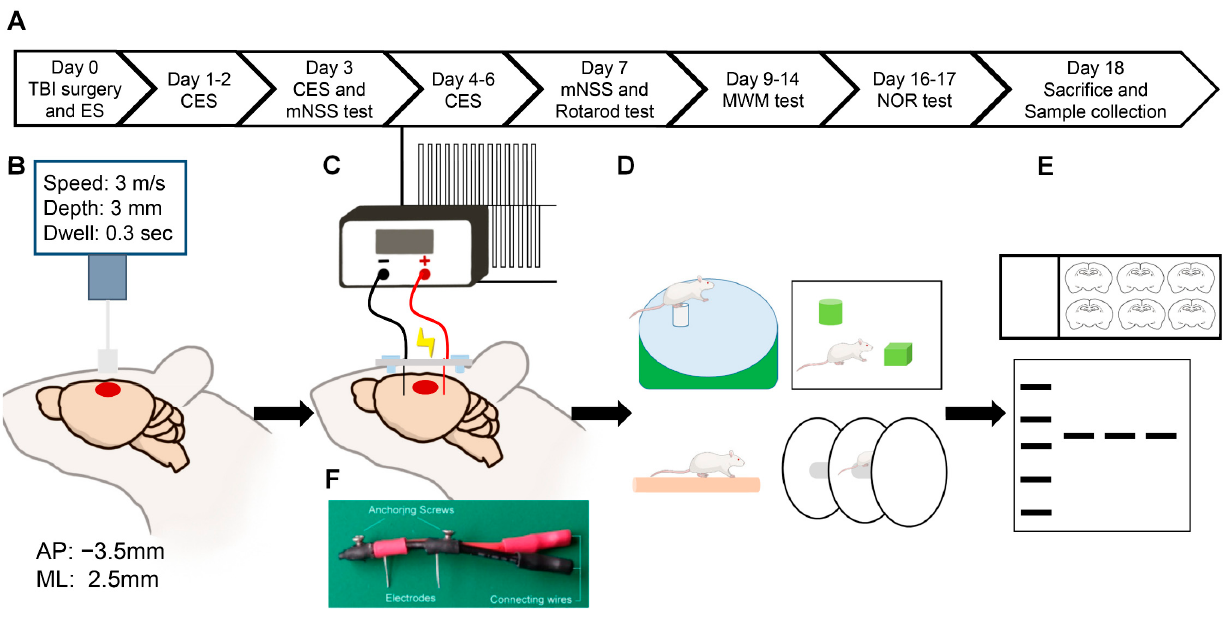
Figure 1. Schematic diagram of the experimental design: ( A ) Schedule of experiments, including traumatic brain injury (TBI) induction, cortical electrical stimulation (ES), modified neurological severity score (mNSS), rotarod test, Morris water maze (MWM) test, and novel object recognition (NOR) test. ( B ) Parameters of control cortical impaction and coordinates of craniotomy. ( C ) Parameters of CES. ( D ) Neurological test. ( E ) Histology and molecular analysis. ( F ) Demonstrating picture of the electrode device.